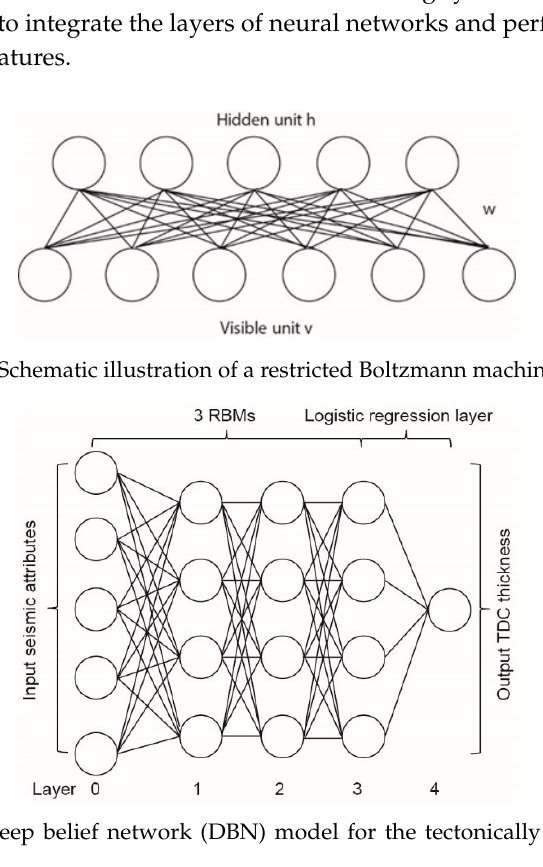
Figure 2. Schematic deep belief network (DBN) model for the tectonically deformed coal (TDC) thickness prediction.